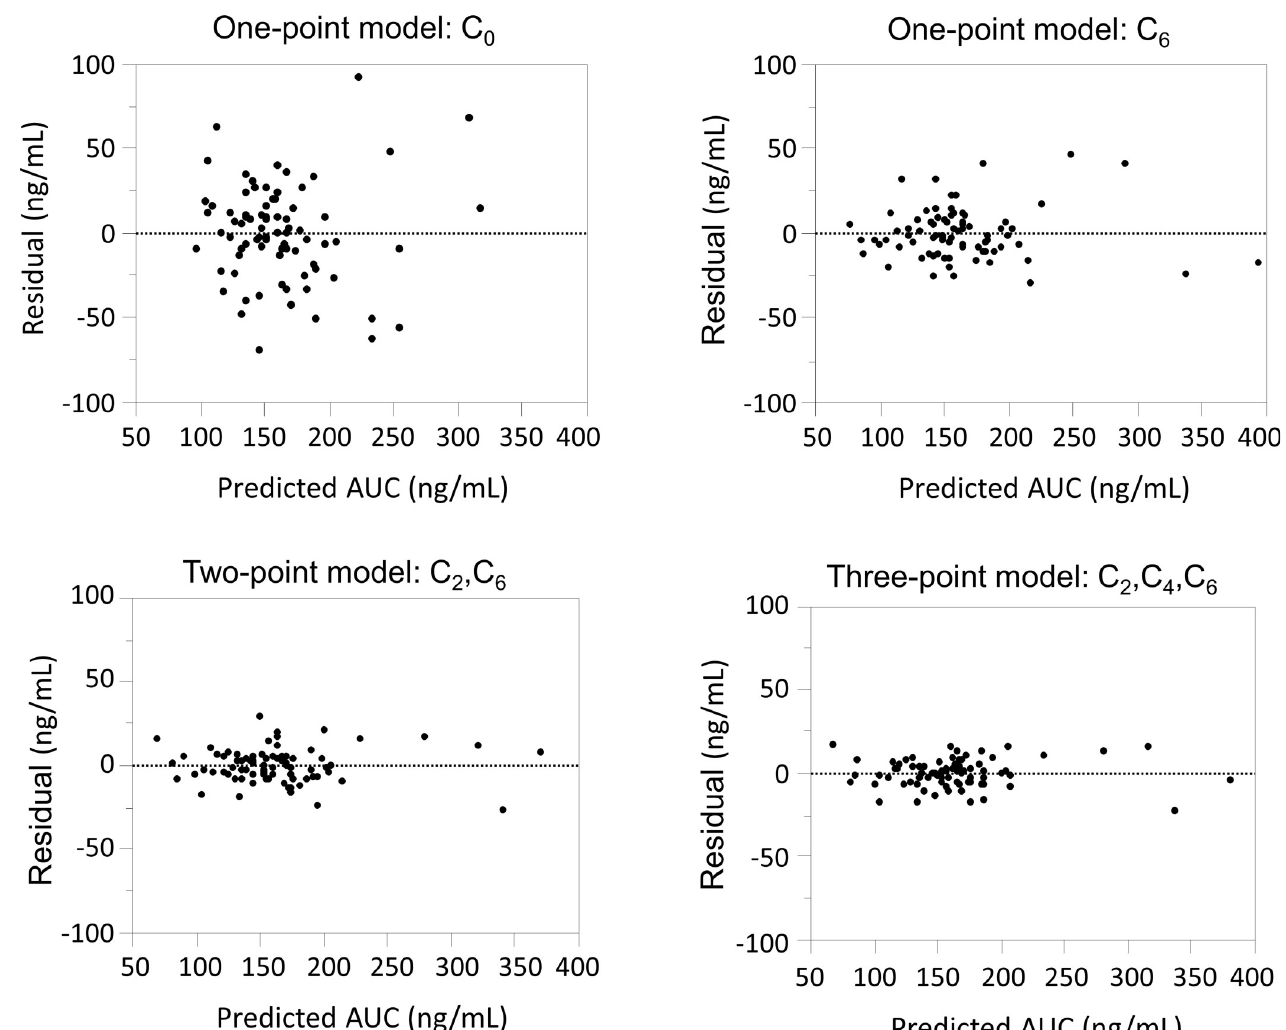
Fig 3. Bland-Altman plots of predictive AUC on the x-axis versus residuals (differences between AUC 0-12 and predictive AUC) on the y-axis. The difference was largest for C 0 and smallest for C 6 for a one-point equation. The combinations of sampling points with C 6 without C 0 (C 2 and C 6 , or C 2 , C 4 and C 6 ) were less